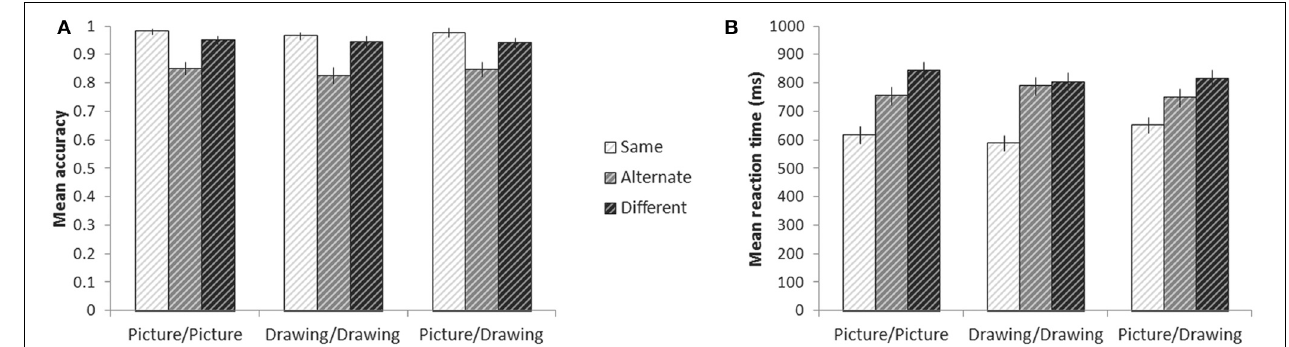
FIGURE 3 | Behavior on the experimental tasks while in the scanner. Mean accuracy (A) and reaction time (B) for each condition. Error bars denote plus or minus one standard error of the